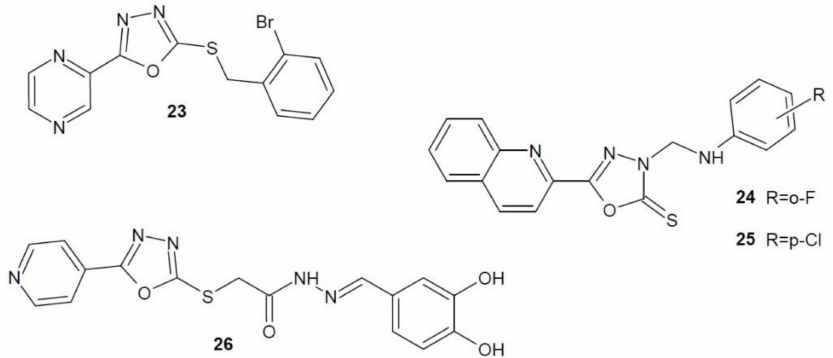
Figure 11. 1,3,4-Oxadiazole derivatives with activity of telomerase